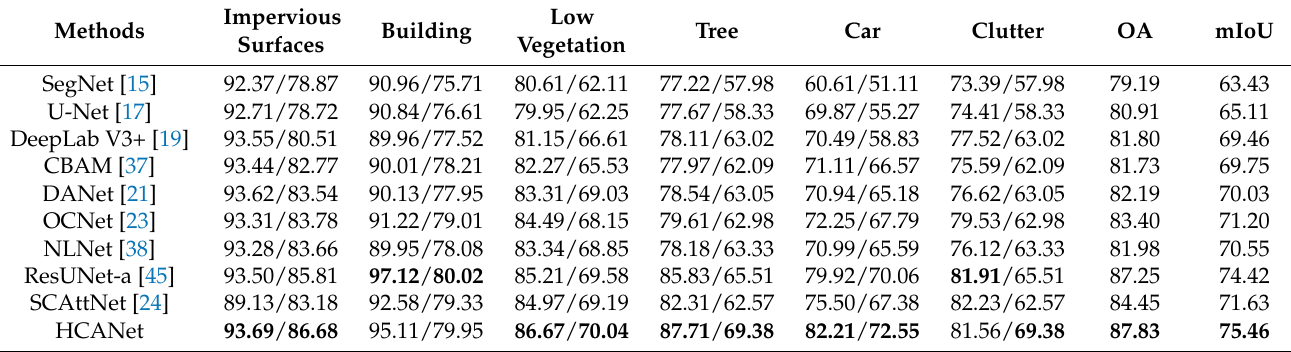
Table 3. Results on Vaihingen dataset. Accuracy of each category is presented in the OA/IoU form, and the bold number indicates the